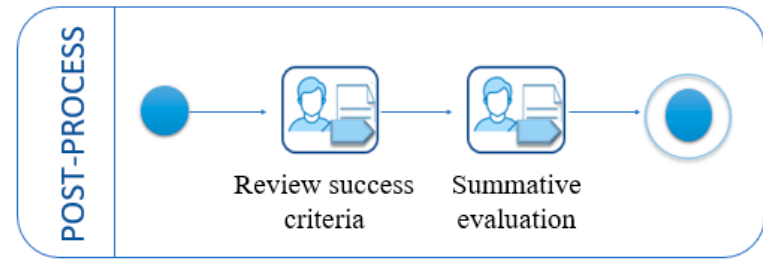
Figure 4. Workflow of post-process activities.